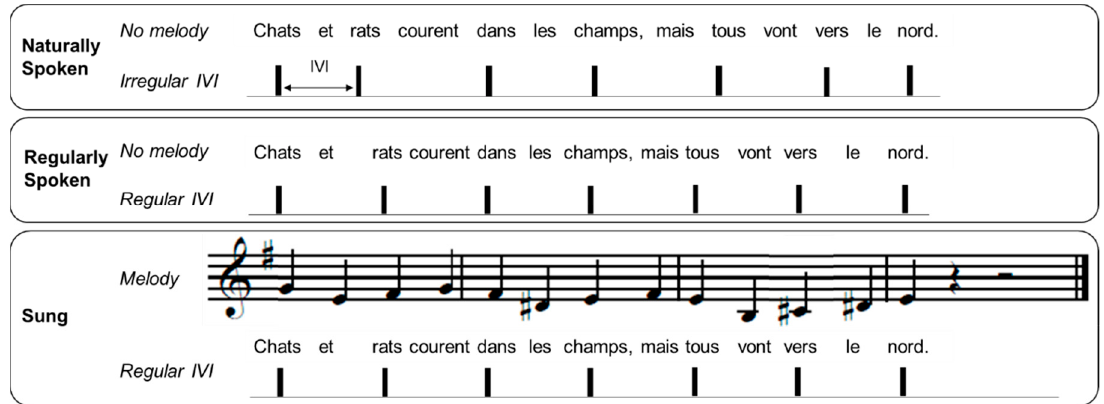
Figure 2. Example of a sentence in the naturally spoken, regularly spoken, and sung conditions. IVI refers to the intervocalic interval between stressed syllables. Table 3. Mean inter-tap interval (ITI) in ms for each group according to material type and